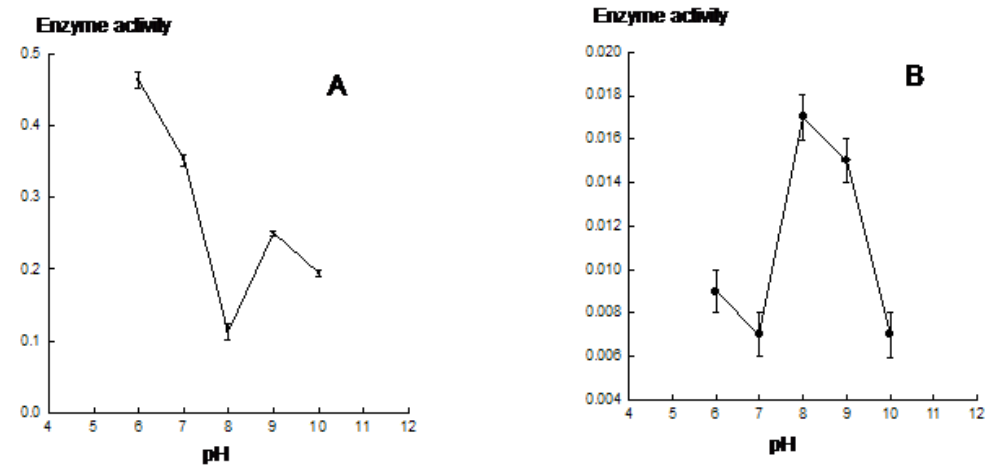
FIGURE 3. Spectrophotometric evaluation of the extracts β -lactamase activity (induced) against ampicillin (A) and cephalexin (B) at 25 o C.